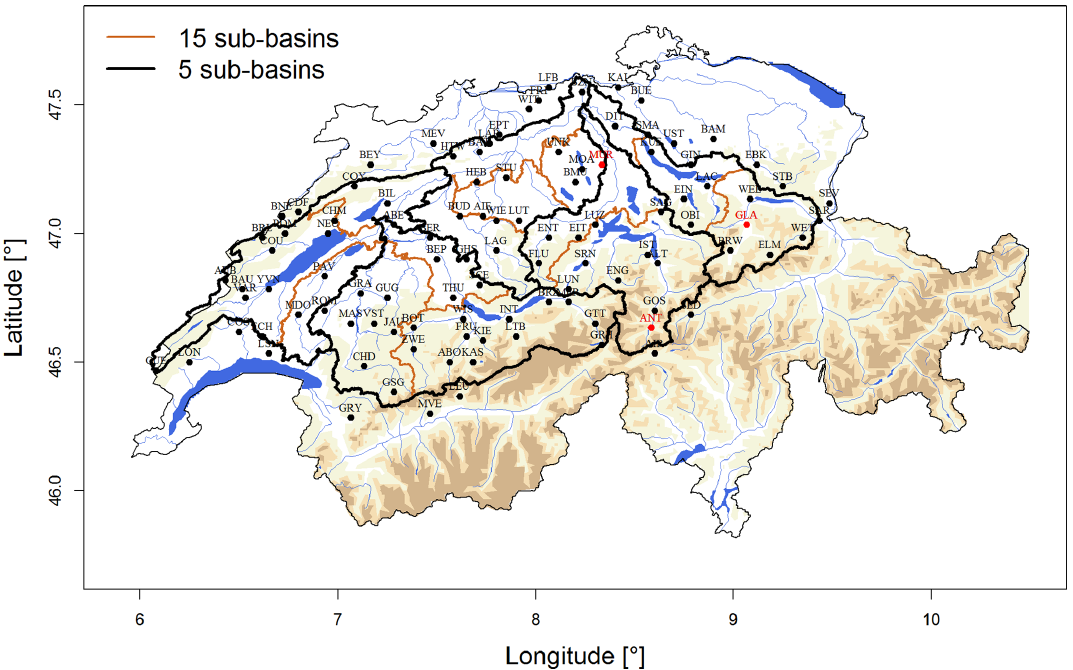
Figure 1. Location of the 105 precipitation stations in Switzerland. Different partitions of the Aare River basin into 5 and 15 sub-basins are shown.